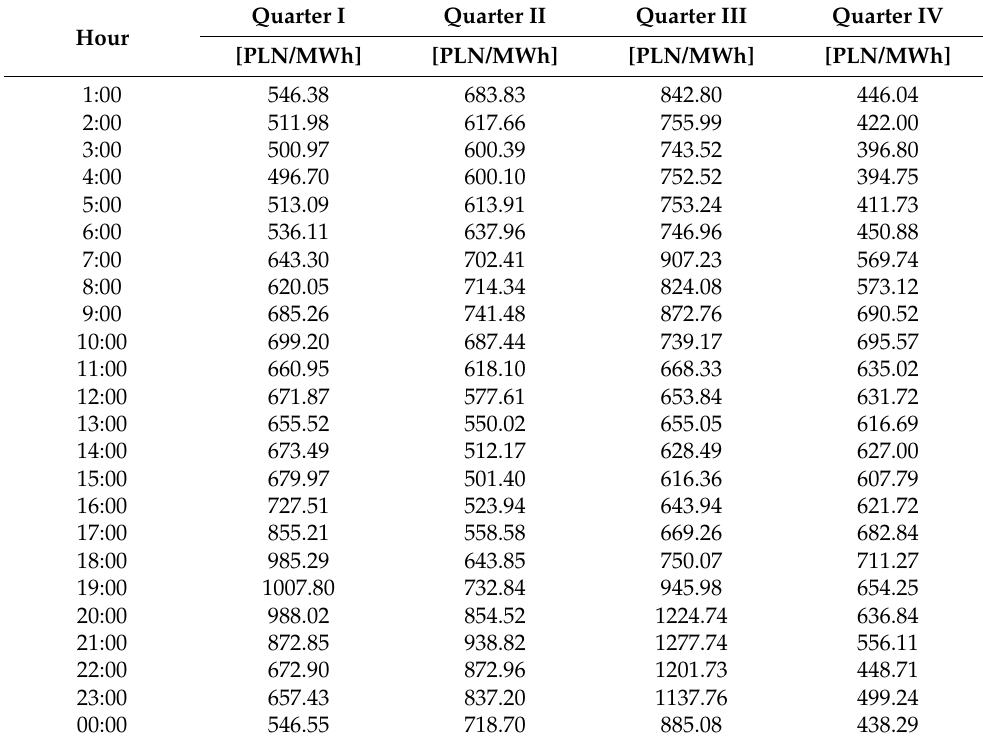
Table 8. Hourly sales prices for the electricity produced from the photovoltaic installation in the first year of the system’s operation. Data from PSE